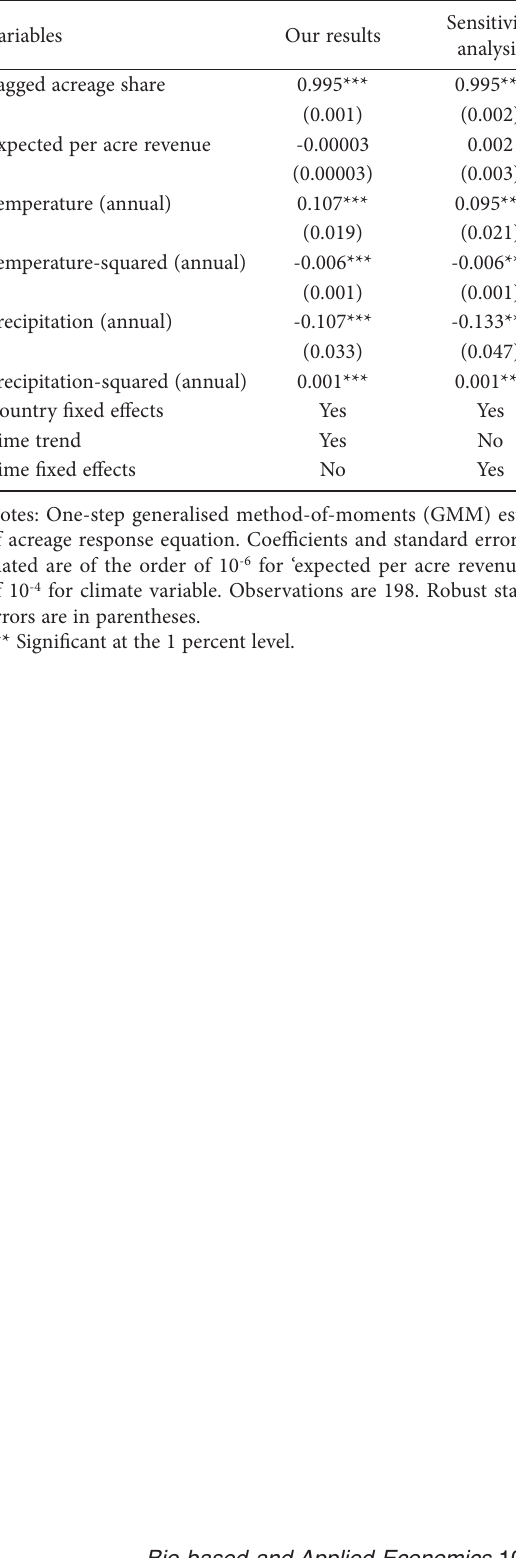
Table A.5. Estimation results for grapevines yield: controlling for